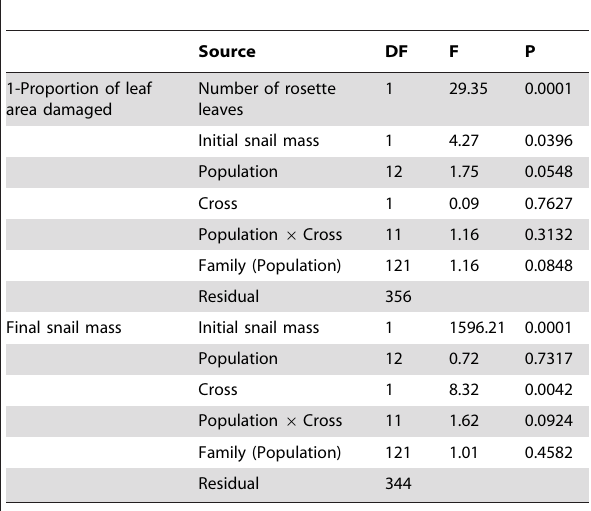
Table 1. Outbreeding effects on resistance in 13 populations of Lychnis flos-cuculi